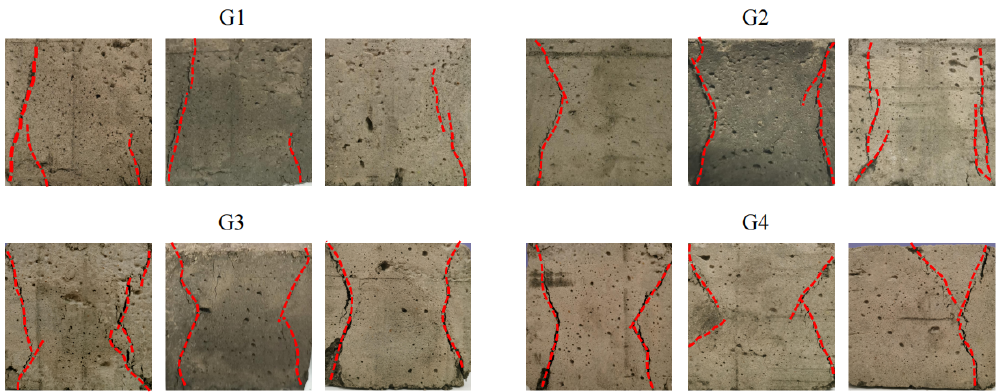
Figure 7. Macro-rupture characteristics of similar materials.